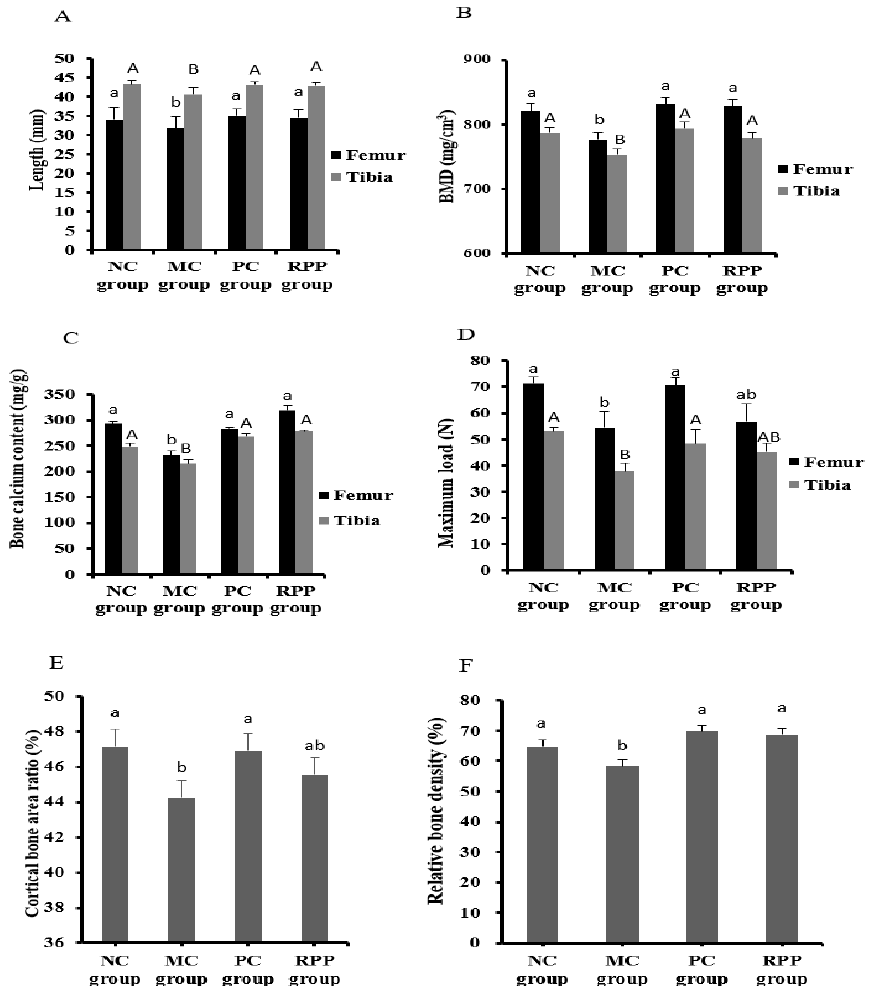
Figure 7. RPP on bone quality in rats. ( A )Femoral and tibial length, ( B ) bone mineral density (BMD), ( C ) bone calcium content, ( D ) maximum load of femur and tibia, ( E ) cortical bone area ratio, and ( F ) trabecular relative bone densityin each group were determined. Groups with different letters are significantly different ( p < 0.05).